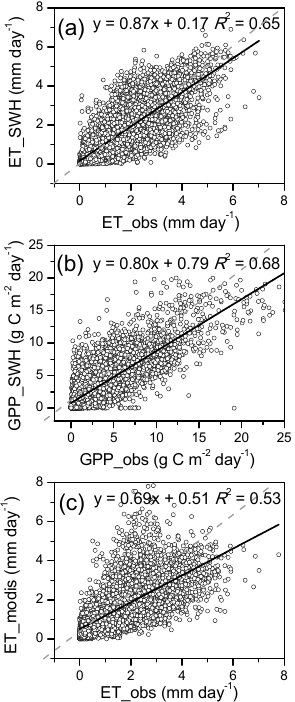
Figure 2. Performances of the SWH model in estimating: ( a ) evapotranspiration (ET); and ( b ) gross primary productivity (GPP); and the performance of the MODIS ET algorithm in estimating ET ( c ). All of the sites used in this study use an eight-day timescale ( n = 9012). ET_EC and GPP_EC are the ET and GPP derived from the measurements using eddy covariance (EC) systems.